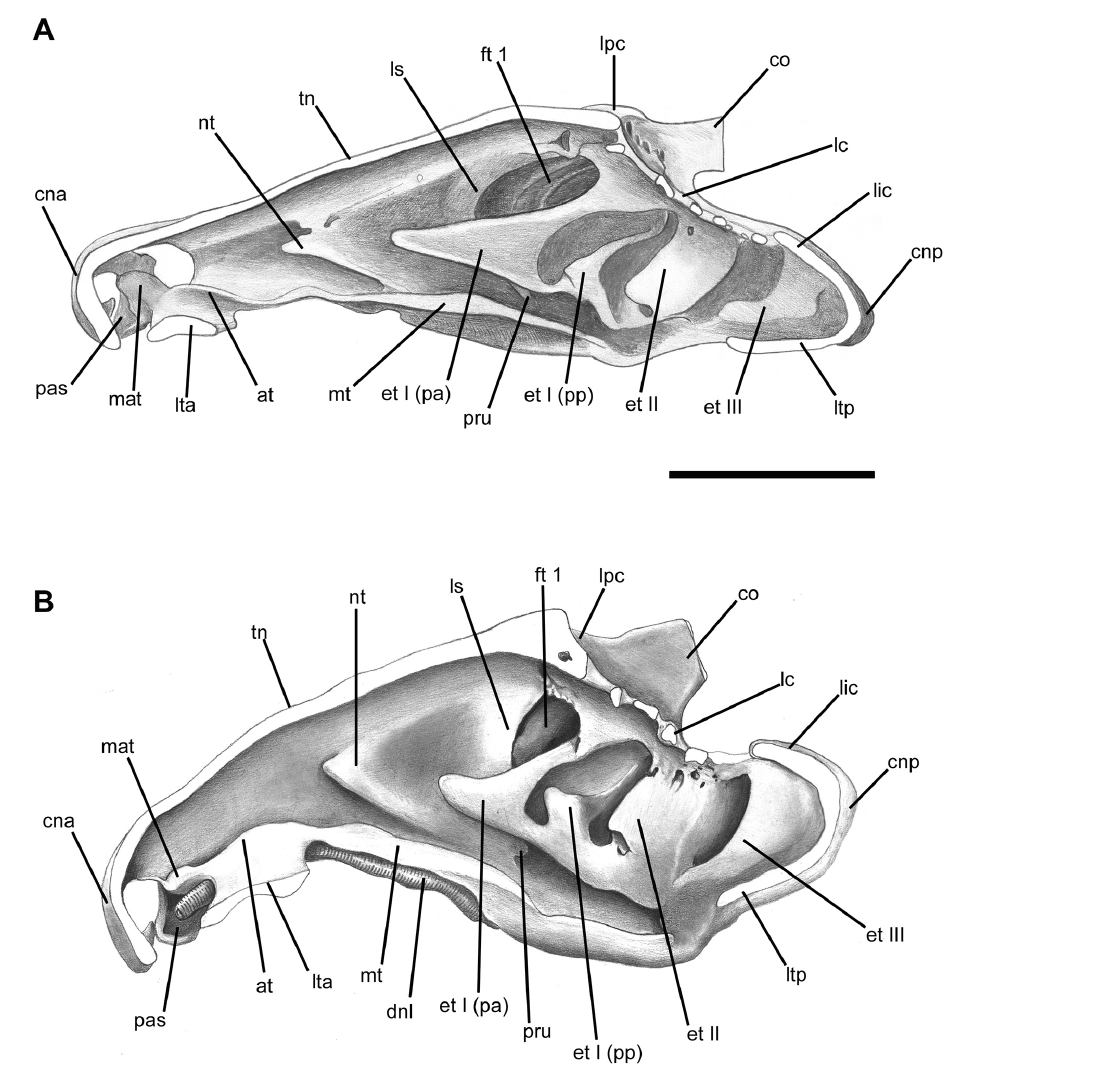
Figure 2. Three-dimensional plate models of the right fetal nasal capsule of (a) Ptilocercus lowii (30mm CRL) and (b) Tupaia belangeri (34 days) in medial view (b) . Abbreviations: at, atrioturbinal; can, cupula nasi anterior; cnp, cupula nasi posterior; co, commissura orbitonasalis; dnl, ductus nasolacrimalis; et I, II, III, ethmoturbinal I, II, III; ft 1, frontoturbinal 1; lc, lamina cribrosa; lic, lamina infracribrosa; lpc, limbus praecribrosus; ls, lamina semicircularis; lta, lamina transversalis anterior; ltp, lamina transversalis posterior; mat, marginoturbinal; mt, maxilloturbinal; nt, nasoturbinal; pa, pars anterior; pas, processus alaris superior; pp, pars posterior; pru, processus uncinatus; tn, tectum nasi. Scale bars equal